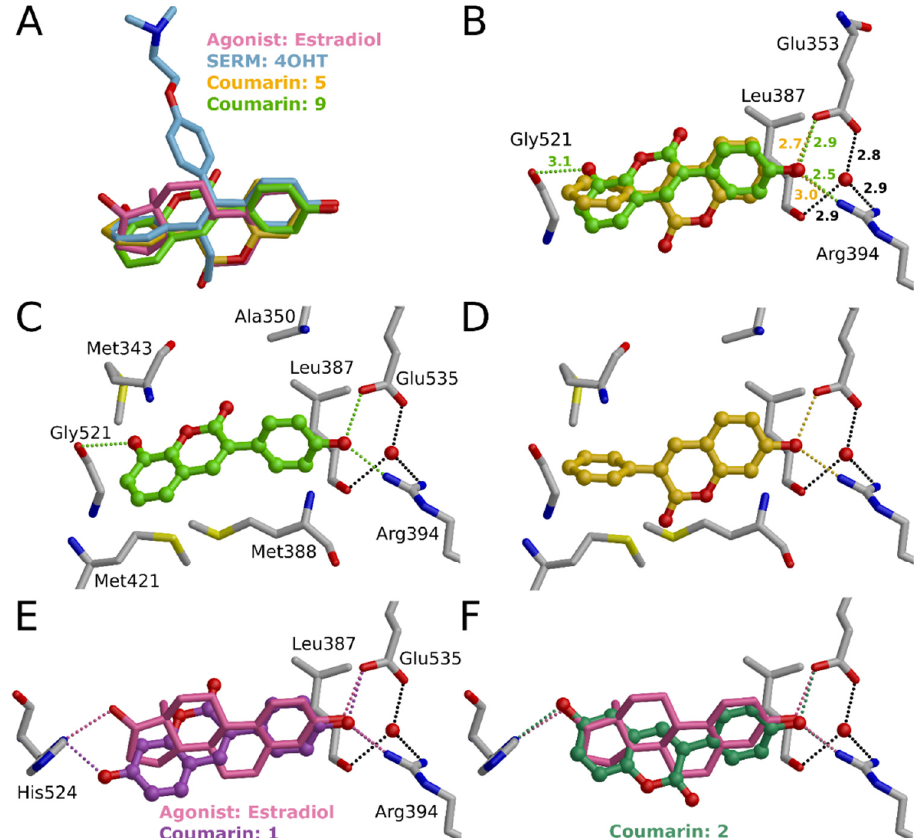
Figure 5. Binding of 3-phenylcoumarins to ER α . ( A ) Comparison of possible binding conformations of estradiol (PDB: 1ERE [12]), 4-hydroxytamoxifen (4OHT; PDB: 3ERT [13]) and two 3-phenylcoumarins 5 and 9 at the binding site of ER α . ( B – D ) Comparison of possible binding modes of 3-phenylcoumarins with hydroxyl either in R2 ( 9 ) or in R5 ( 5 ) position. Different hydroxyl substituent position makes coumarin core to flip so that favorable interactions with Glu353 and Arg394 are formed. ( E , F ) Comparison of 3-phenylcoumarins having two hydroxyl substituents. The most obvious estradiol mimic, compound 1, approaches His524 at a different angle compared to D-ring hydroxyl of estradiol, whereas compound 2 forms a similar hydrogen-bonding network as estradiol.